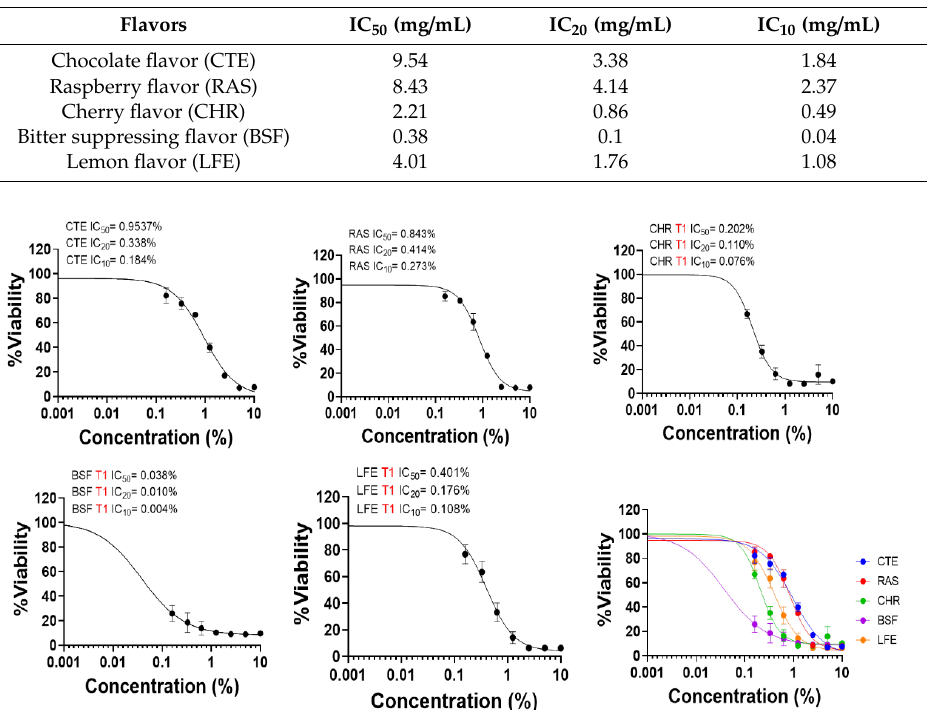
Table 1. The inhibitory concentration (IC 50 , IC 20 , IC 10 ) values of selected flavors. Values are presented as mean ( n = 3).